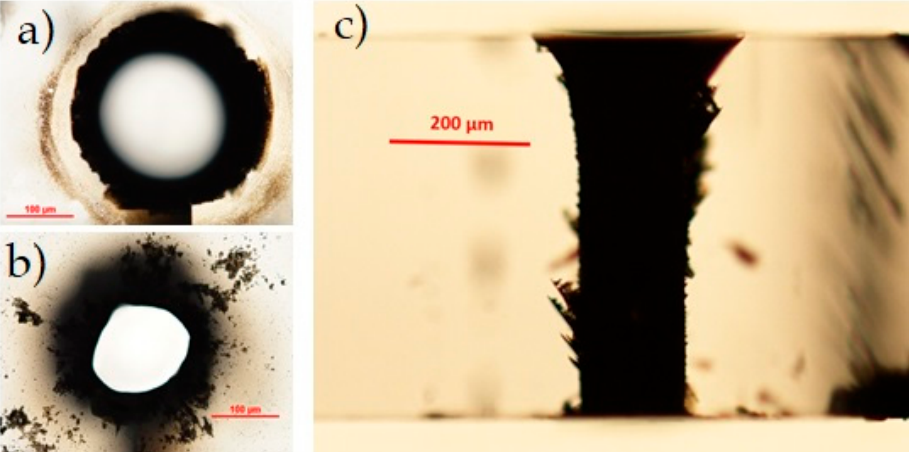
Figure 12. Optical microscope image of a through-hole performed in a 500 μ m-thick diamond sample, with 100 writing circles, pulse duration 6 ps and pulse energy 310 μ J. Top ( a ), bottom ( b ) and lateral view ( c ).